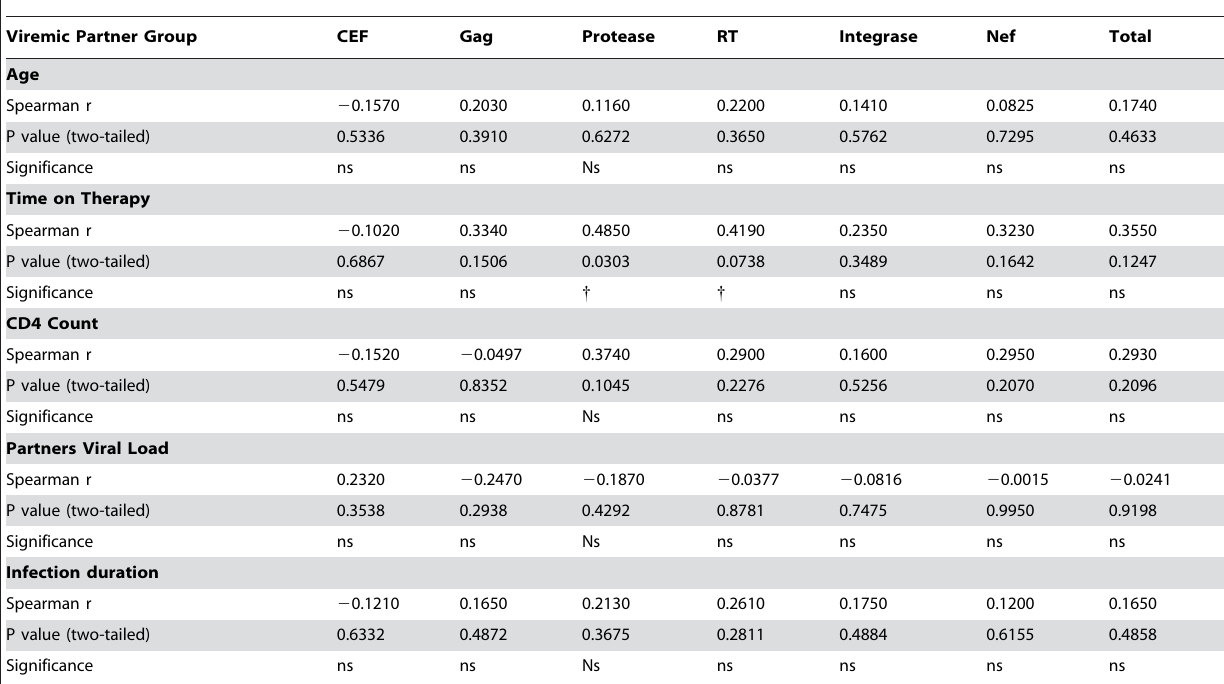
Table 4. The influence of clinical parameters on T cell